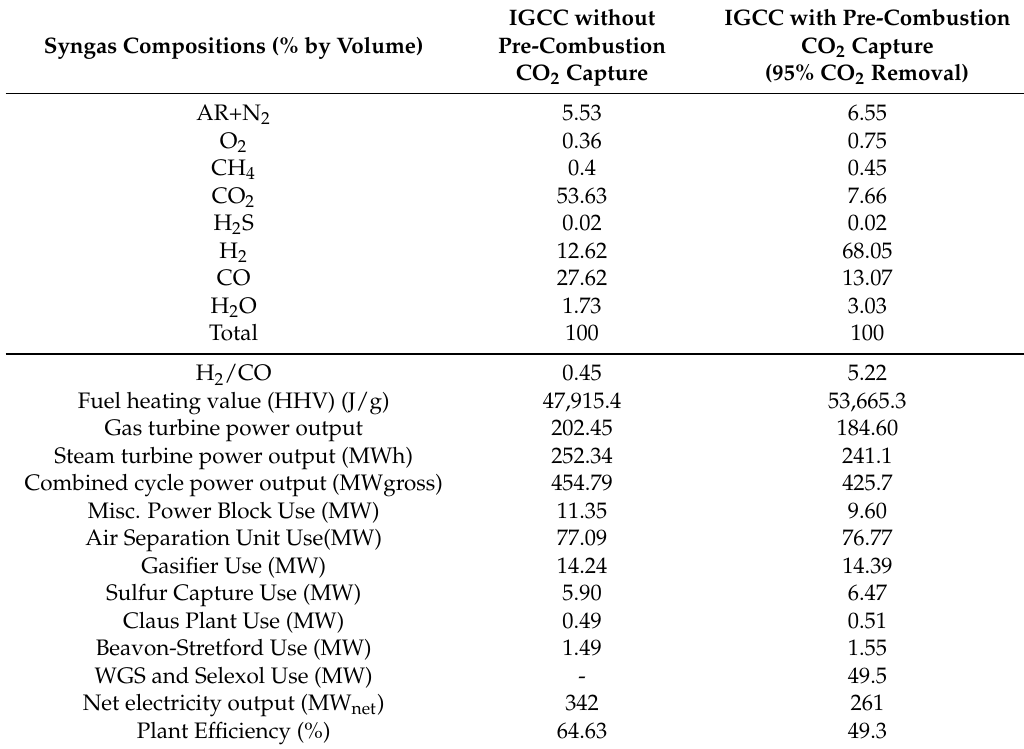
Table 6. Model results of IGCC with and without